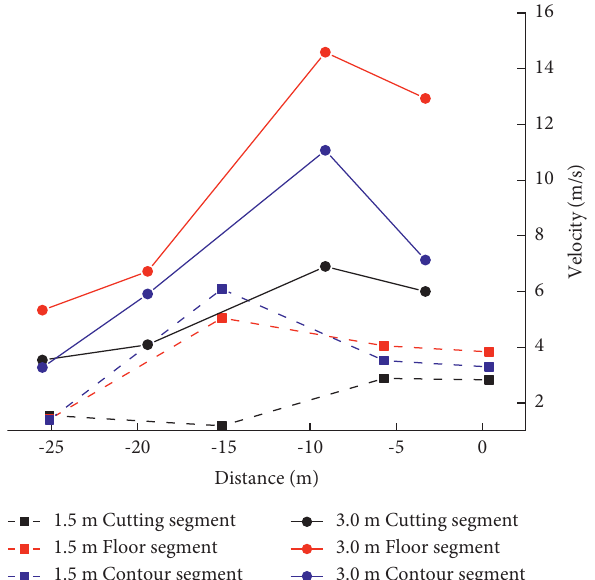
Figure 7: Comparison of the vibration velocity of the typical blasting segments with different footage conditions behind the corresponding blasting face.